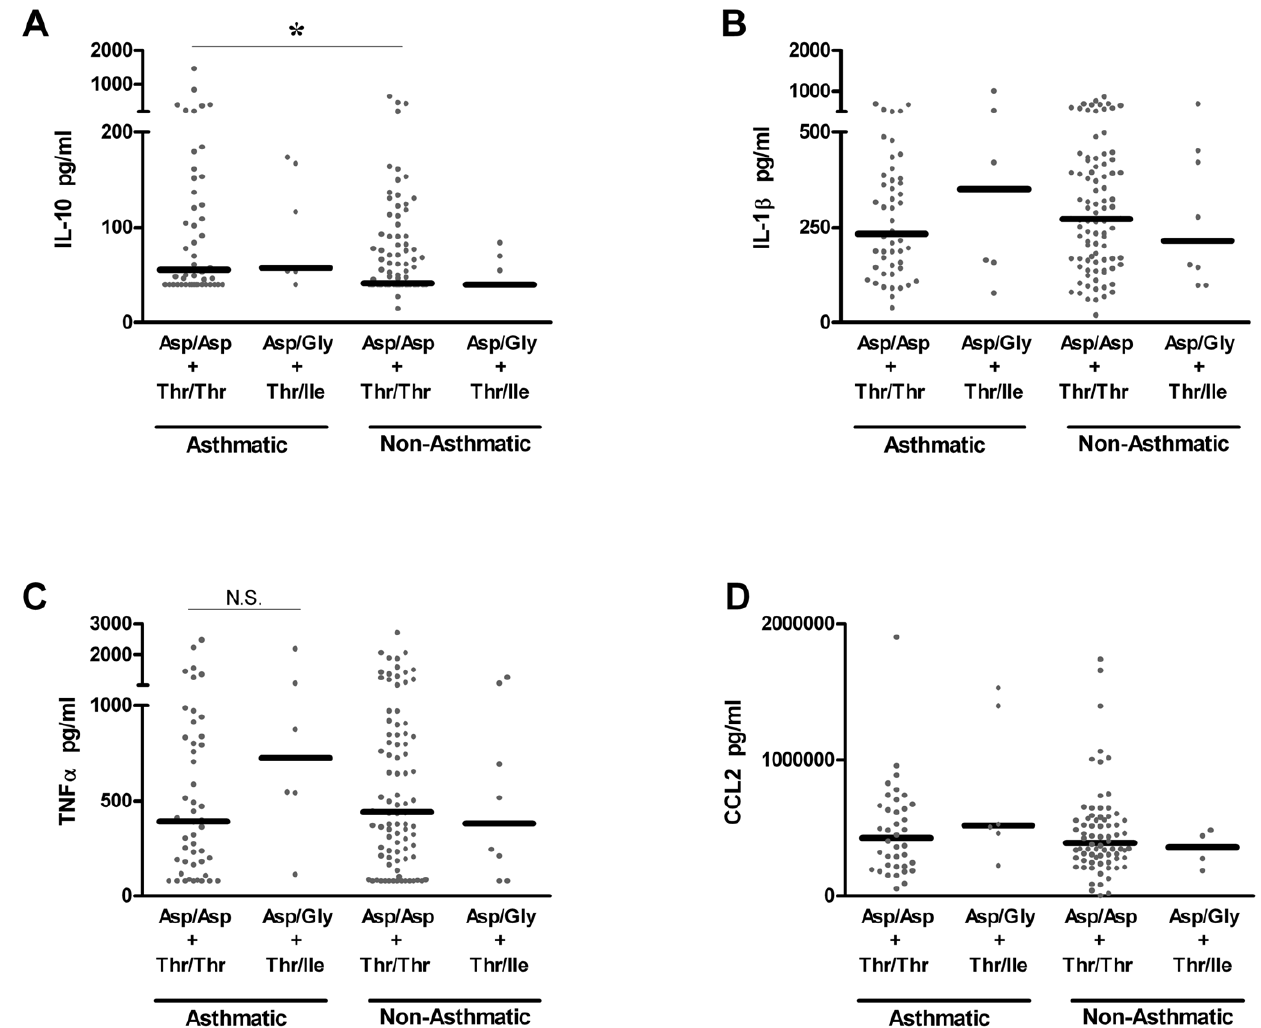
Figure 2. Similar LPS-driven cytokine responses are expressed by children with differing TLR4 haplotypes, independent of current asthma. IL-10 ( A ), IL-1 b ( B ), TNF a ( C ) and CCL2 ( D ) were assessed as detailed above. * P , 0.05, with all other comparisons P . 0.05.